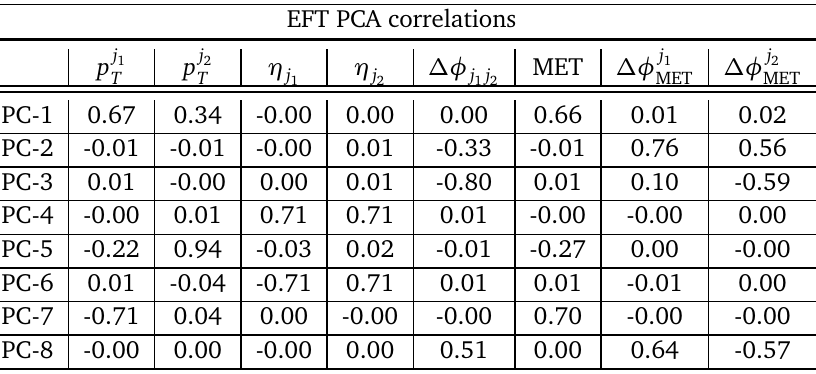
Table B2: PCA original features to principal component correlations for the EFT sim- plified framework (rounded to 2 d.p.).